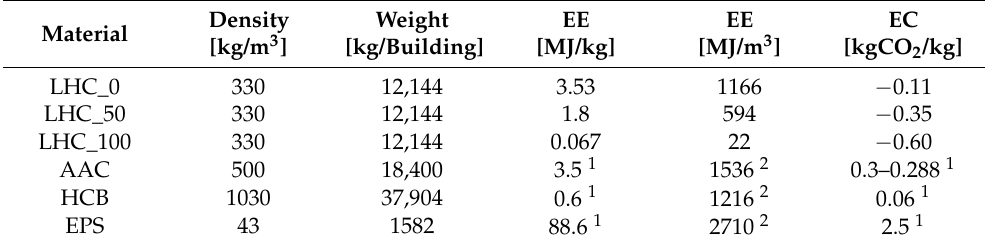
Table 2. EE and EC values of the tested LHC mixtures (based on Table 1), as compared to conventional materials.